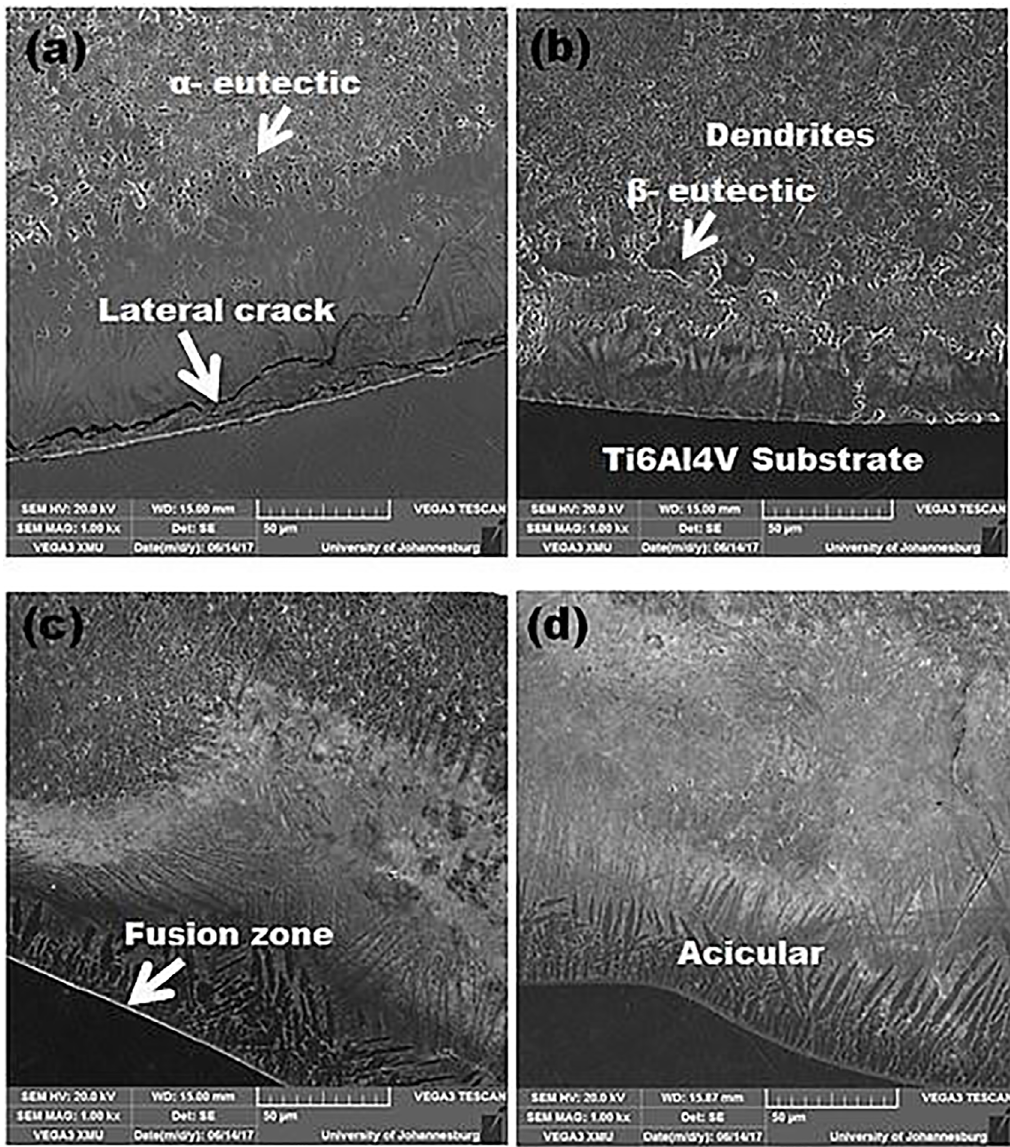
Figure 3. SEM microstructures of deposited samples (a) DC1 deposited with a scanning speed of 0.3 m/min, (b) DC2 deposited with a scanning speed of 0.5 m/min, (c) DC3 deposited with a scanning speed of 0.9 m/min, (d) DC4 deposited with a scanning speed of 1.2